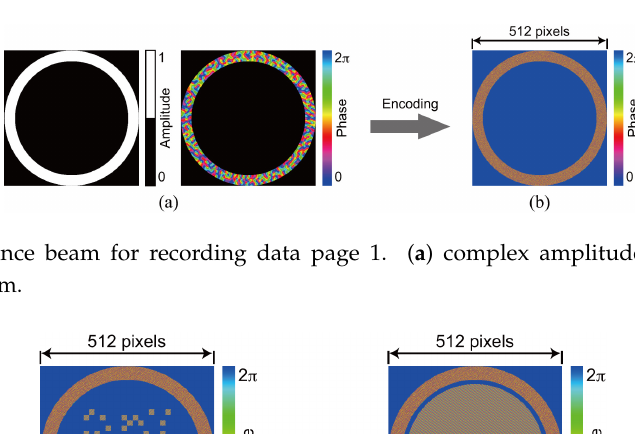
Figure 3. Data page 1. ( a ) complex amplitude distribution and ( b ) phase hologram.